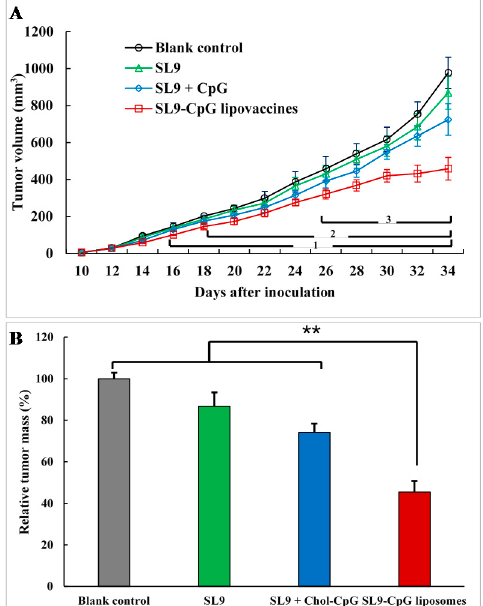
Figure 4. Anticancer effect in melanoma-bearing mice after immunization with SL9-CpG lipovaccines or controls. Tumor volumes after treatment with SL9-CpG lipovaccines (5 µ g / mL SL9, 30 µ g / mL CpG) or controls ( A ). Data are presented as mean ± standard deviation ( n = 8). p < 0.05; 1, vs. physiological saline; 2, vs. free SL9; 3, vs. free SL9 + CpG. Relative tumor weight (%) after treatment with SL9-CpG lipovaccines (5 µ g / mL SL9, 30 µ g / mL CpG) or controls ( B ). Data are presented as mean ± standard deviation ( n = 8). ** p < 0.01.